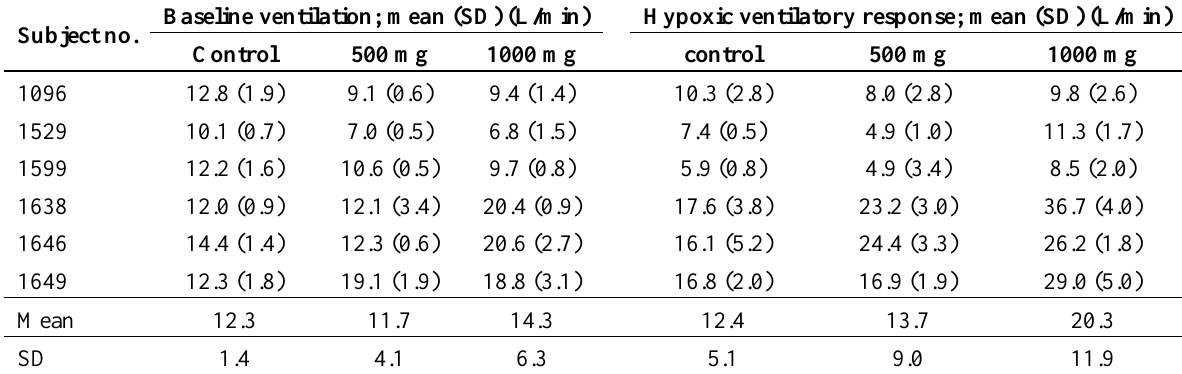
Table 1. Effects of amifostine on basal minute ventilation and the acute hypoxic response (absolute values). Control, 500 mg and 1000 mg amifostine shown in columns, in